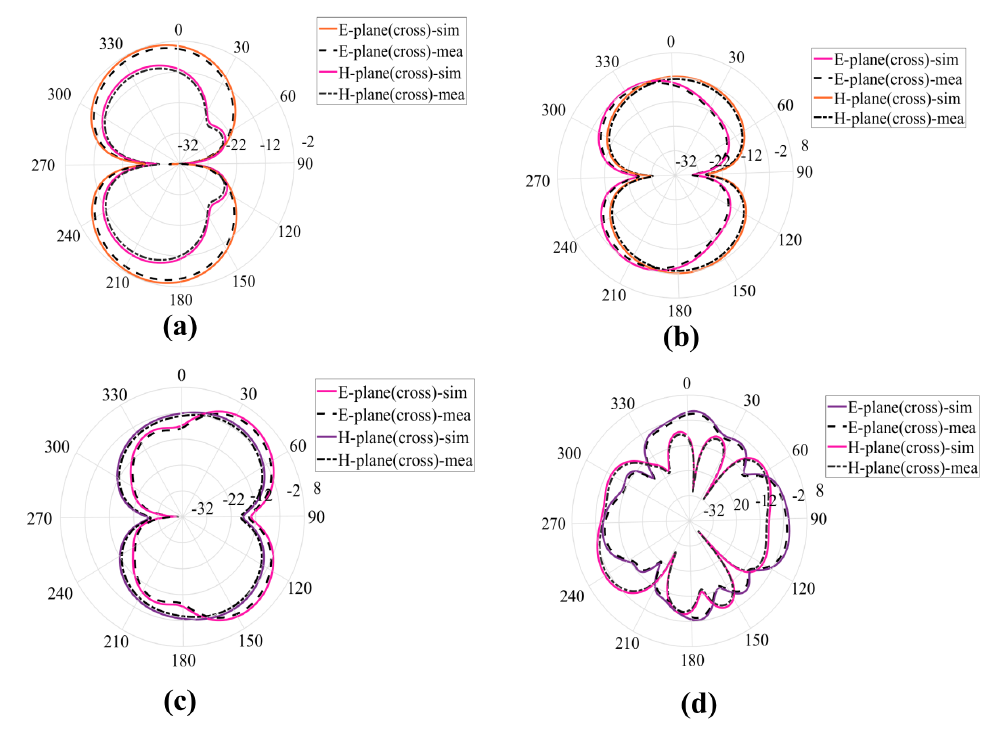
Figure 11. E-H plane radiation patterns for Cross-polarization for different frequencies ( a ) 2.5 GHz ( b ) 3.5 GHz ( c ) 6.5 GHz ( d ) 17